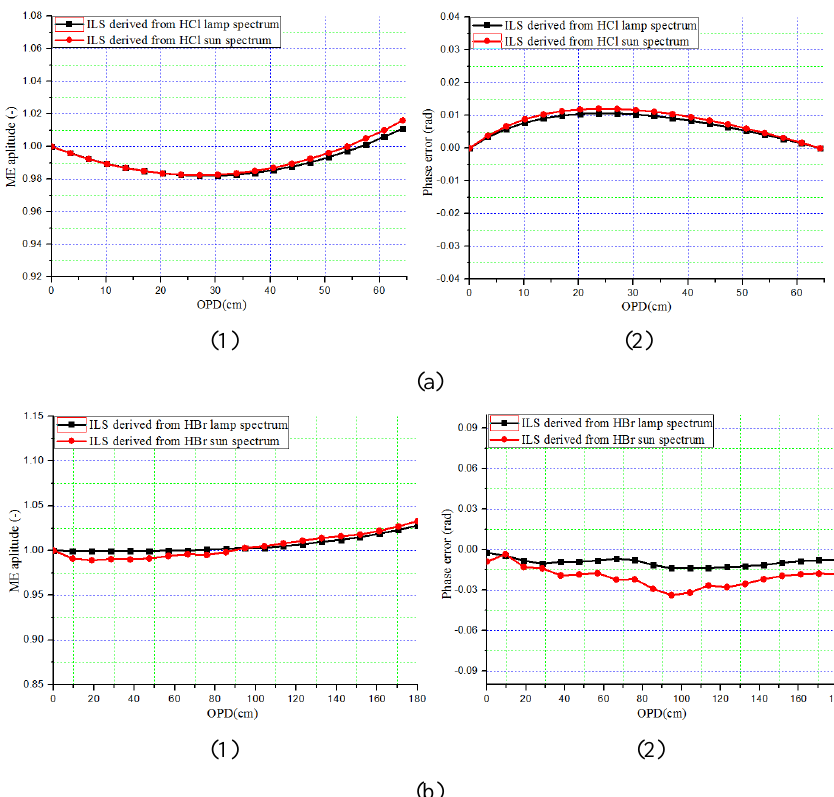
Figure 6. ILS retrievals derived from lamp (black lines) and sun spectra (red lines). Panel (a1) shows ILS modulation efficiencies deduced from HCl lamp and sun spectra, (a2) shows ILS phase errors deduced from HCl lamp and sun spectra, (b1) shows ILS modulation efficiencies deduced from HBr lamp and sun spectra, and (b2) shows ILS phase errors deduced from HBr lamp and sun